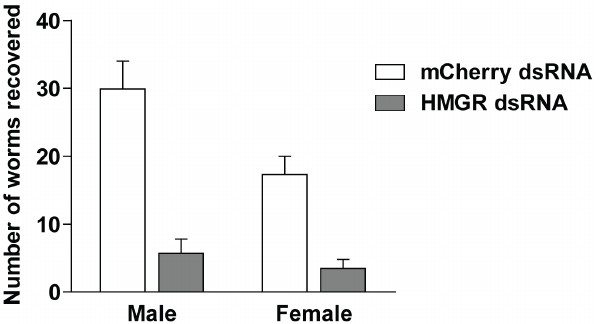
Figure 5. RNAi of SmHMGR severely compromises parasite survival invivo . Newly transformed somules were incubated for 2.5 days in the presence of mCherry dsRNA or HMGR dsRNA as described in the text. Parasites were then injected subcutaneously into Swiss Webster mice (5 mice per dsRNA treatment). After 34 days, mice were euthanized and the portal system perfused to recover parasites for counting. Bars represent means 6 S.D. across two independent experiments. Using Student’s t -test, worm recovery after exposure to HMGR-dsRNA was significantly different from mCherry controls ( p ,